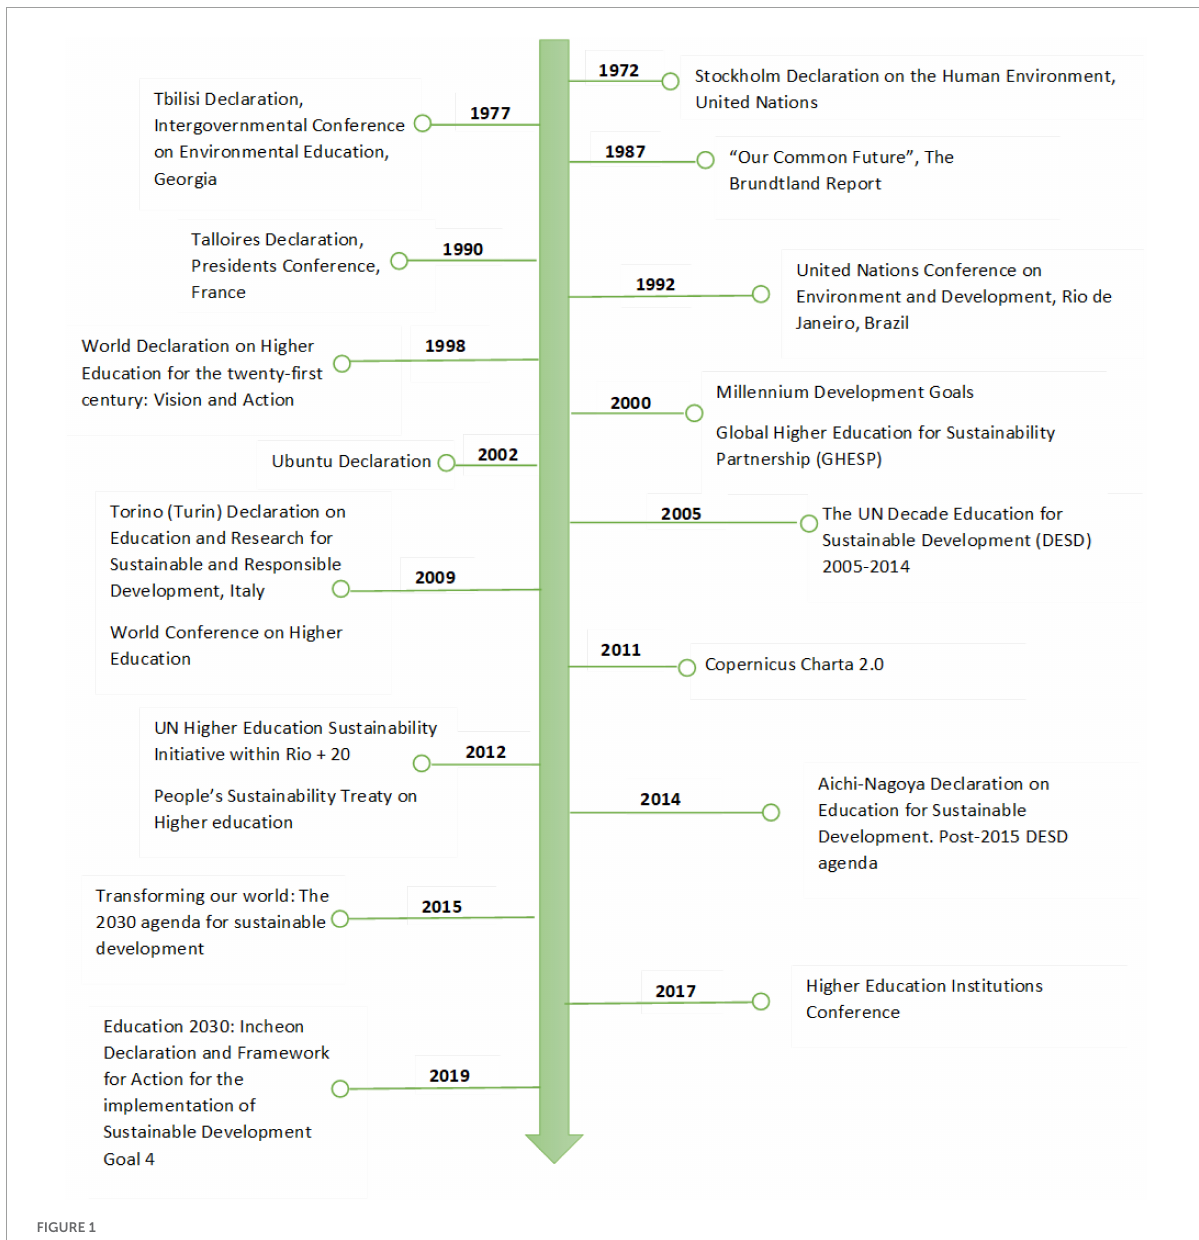
FIGURE1 Timeline of major international sustainability